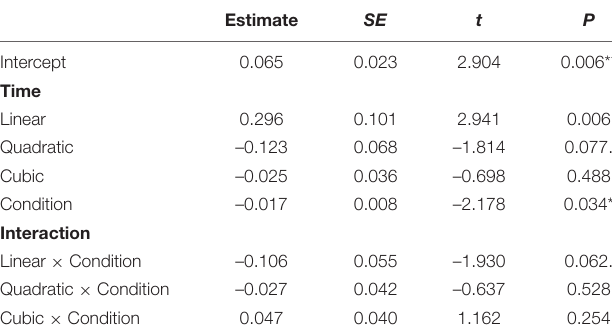
TABLE 3 | Results of growth curve analysis on CR-T2 target ratios and SR-T3 competitor ratios when hearing CR-T2 words.